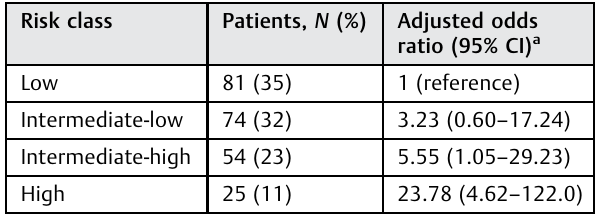
Table 2 Baseline characteristics of the 272 patients with acute pulmonary embolism divided according to the survival status at